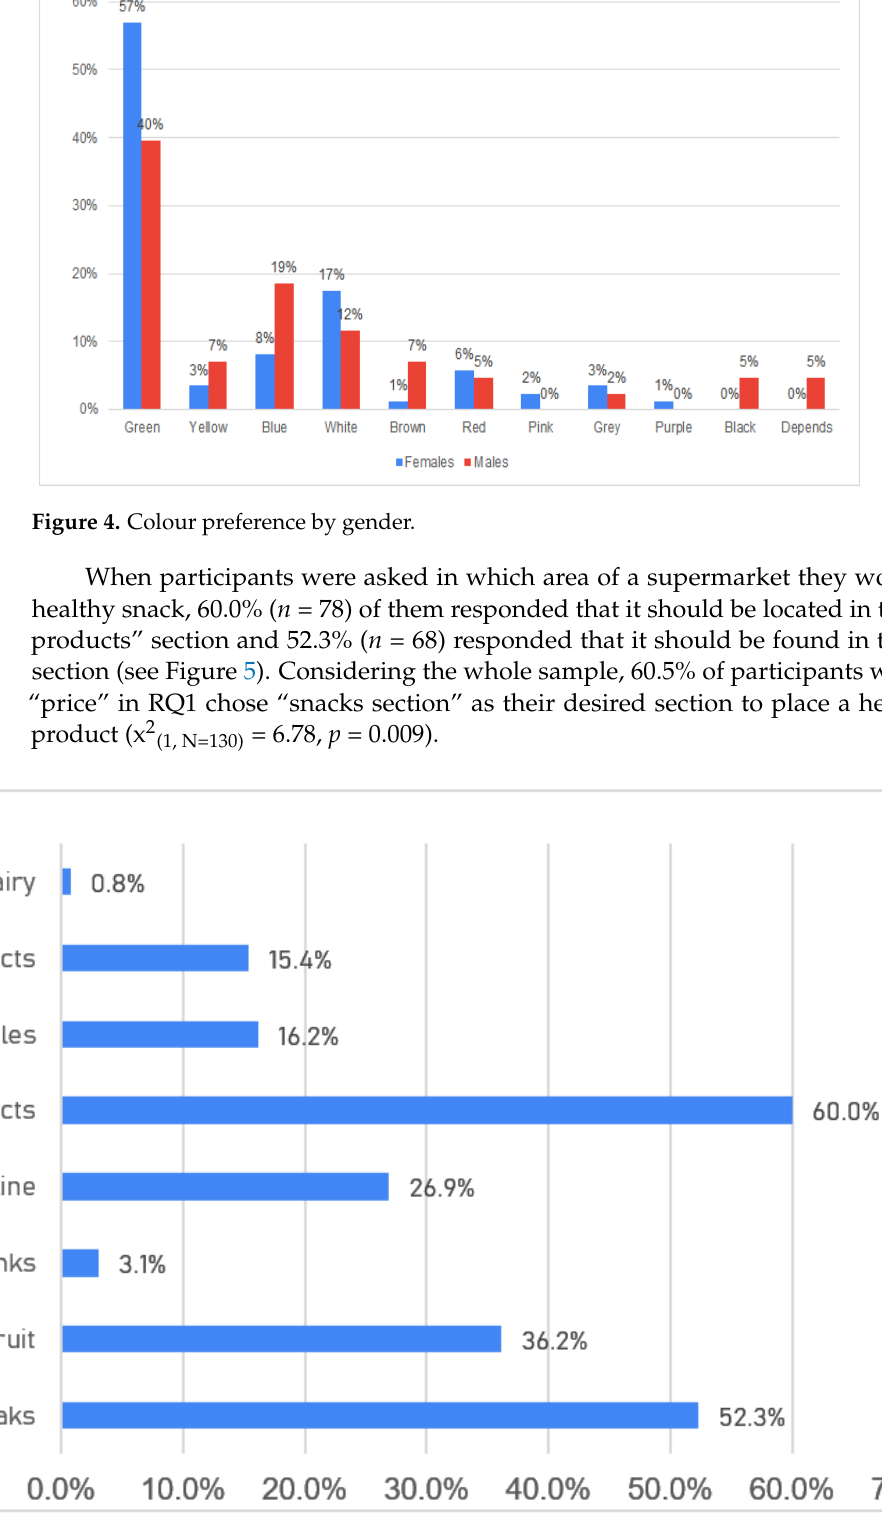
Figure 3. Packaging colour related to “healthy” .